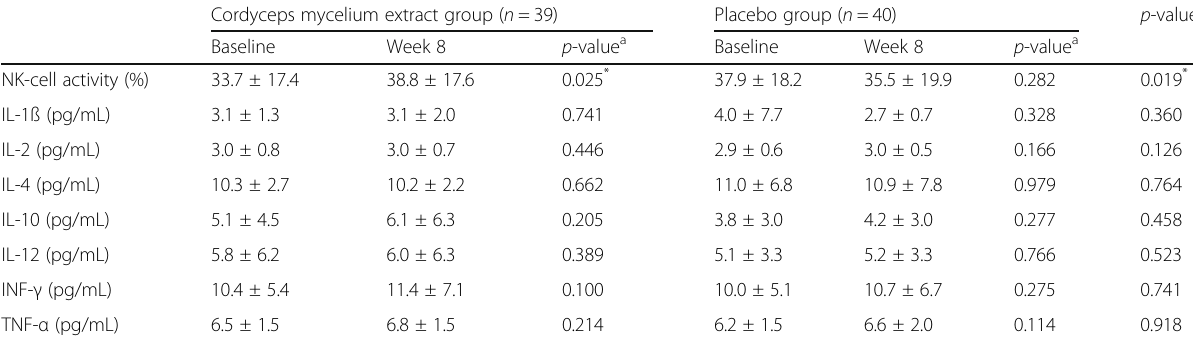
Table 3 NK-cell activity and cytokine cluster analysis obtained prior to and after treatments from the two